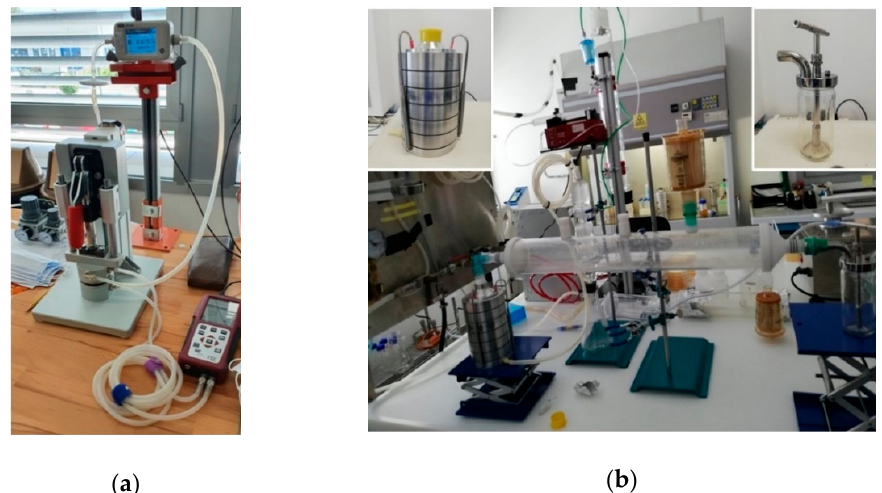
Figure 2. The test system for DP ( a ) and BFE ( b ) at Universit à di Modena e Reggio Emilia (UNIMORE). In the insets of the ( b ) image, the Andersen cascade impactor (top left) and the aerosol generator (top right) are shown.